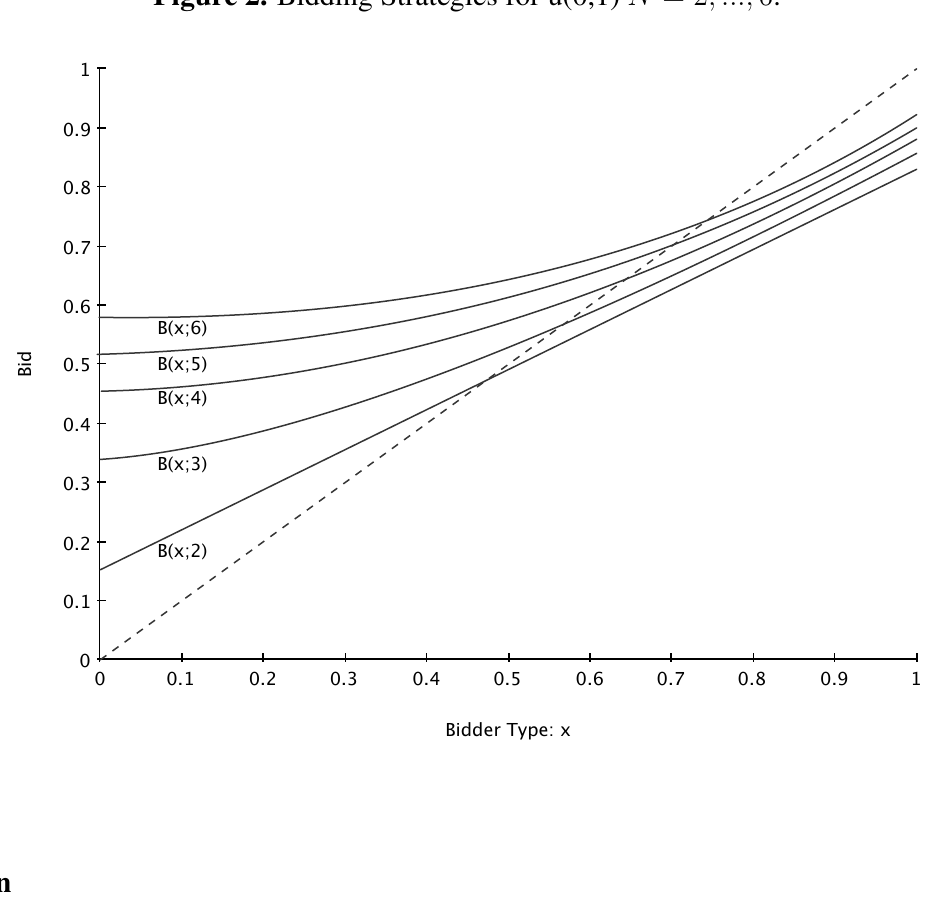
Figure 2. Bidding Strategies for u(0,1) N = 2 , ..., 6